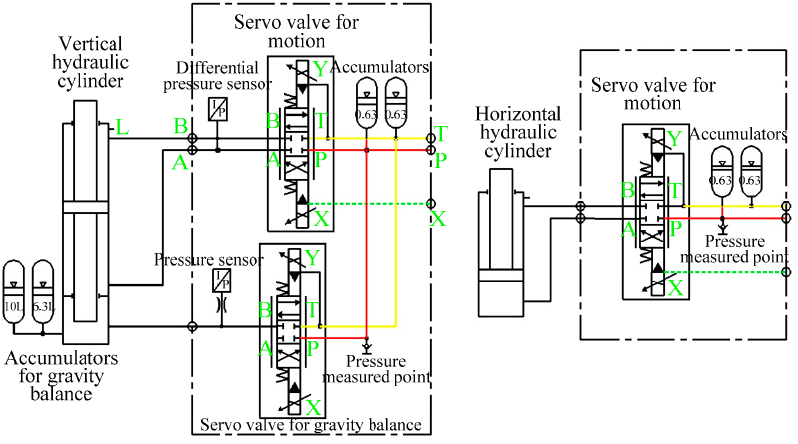
Figure 2. The hydraulic principle diagram of the designed valve-controlled hydraulic cylinders.